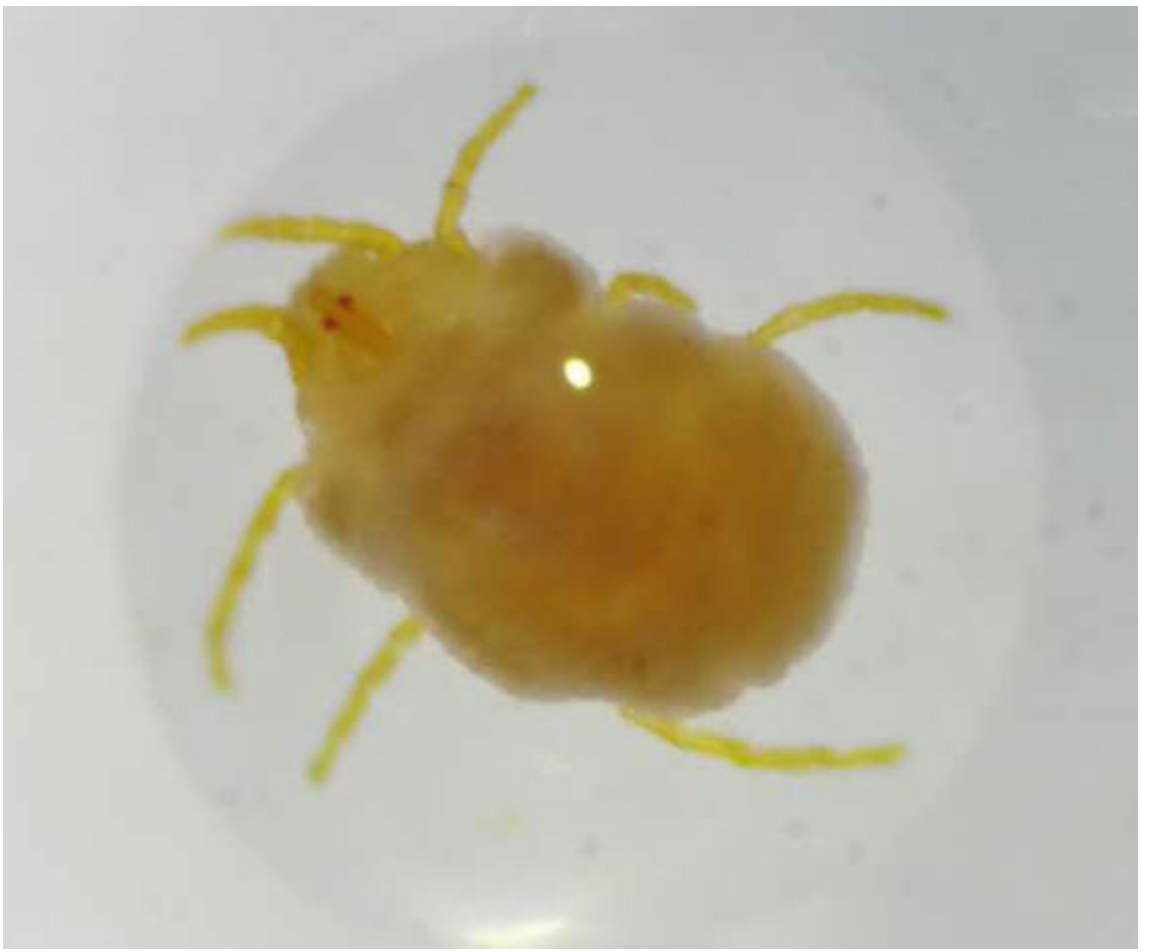
Fig. 6. Pentachares sinensis Li & Guo gen. et sp. nov., holotype, ♀ (GUGC GD-LI-20190801). Dorsal view,